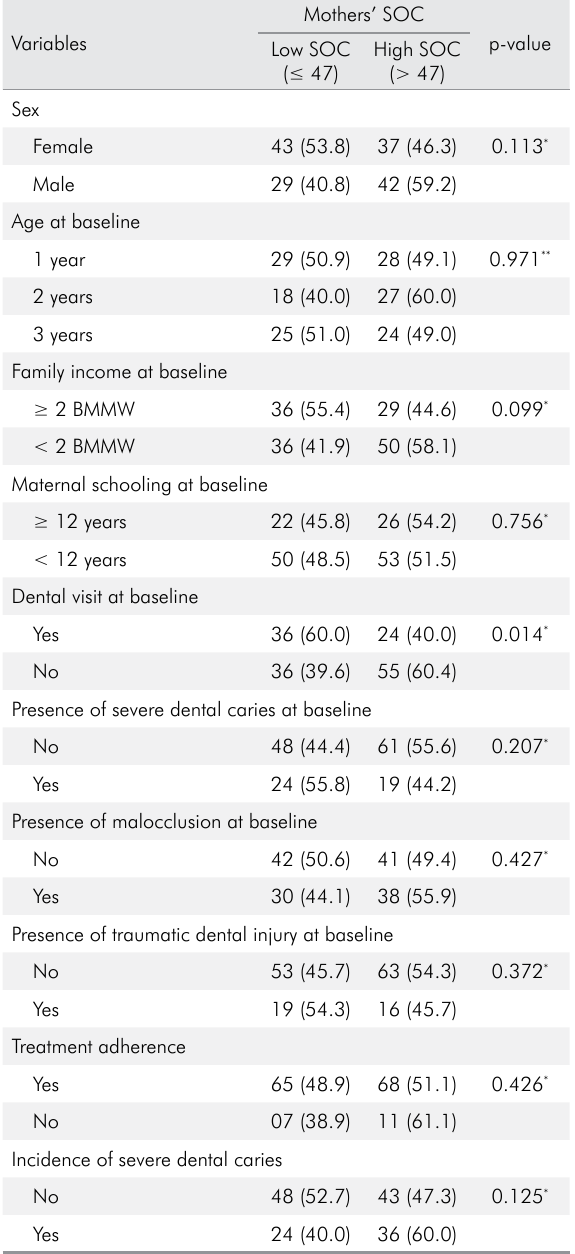
Table 4. Sample distribution according to mothers’ sense of